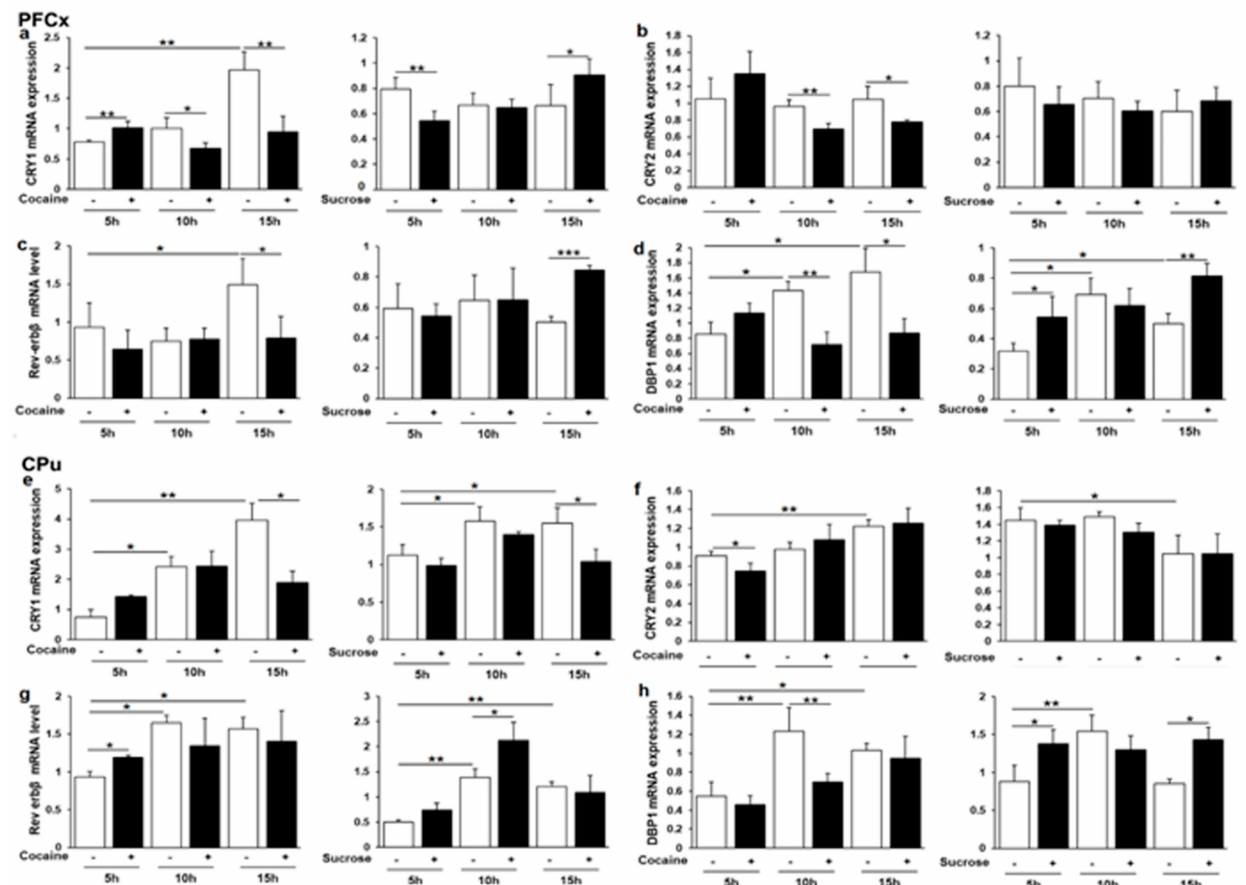
Figure 6. Cry1 , Cry2 , Rev-erb β and Dbp1 mRNA levels in the PFCx and the CPu ( a,b,d–f,h ) . Relative mRNA levels ( c,g ) of the 4 genes and statistical analyses were performed, as described in legend to Figure 2. * p < 0.05, ** p < 0.01, *** p <